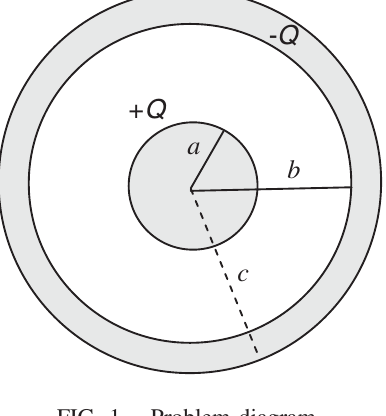
FIG. 1. Problem diagram.